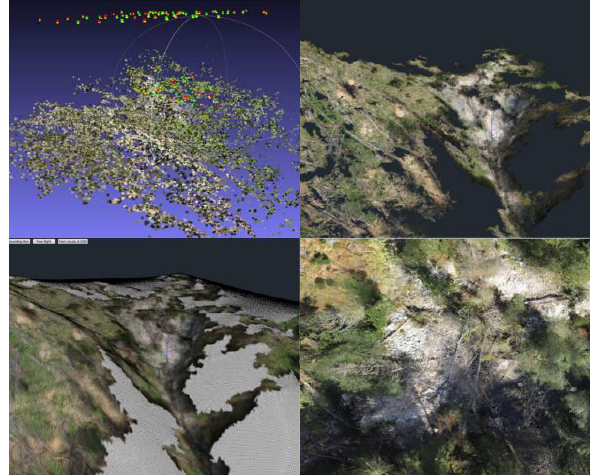
Figure 4. Results of standard photogrammetric workflow (upper left – sparse pointcloud, upper right – point cloud of points belonging to terrain, lover left – digital terrain model, lower right – digital